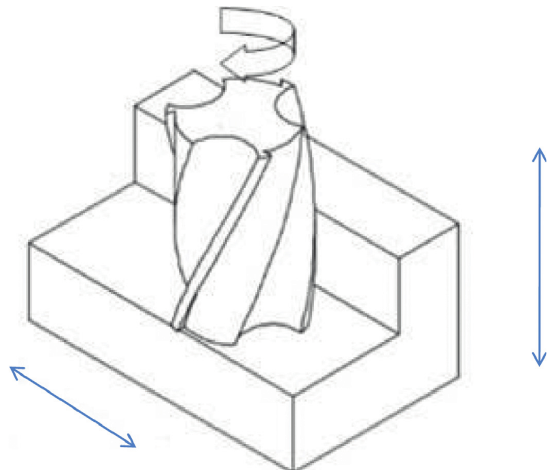
Figure 1: Main vibration direction in the UVARM process.